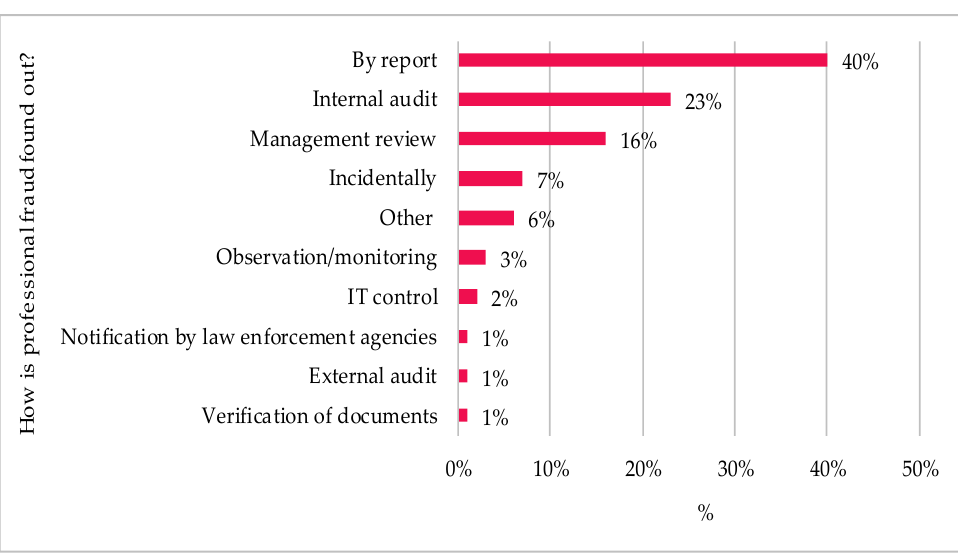
Figure 4. Most common professional fraud schemes in Eastern Europe and Western/Central Asia.